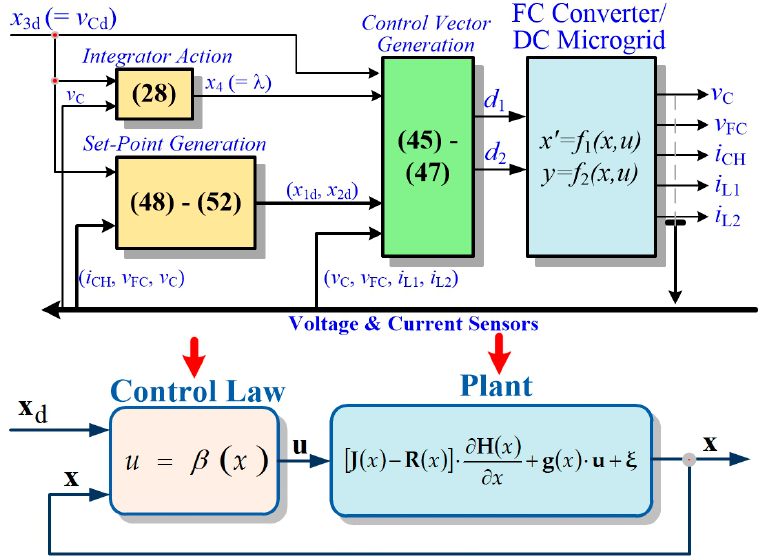
Figure 8. Proposal of the adaptive Hamiltonian energy control for an FC converter.